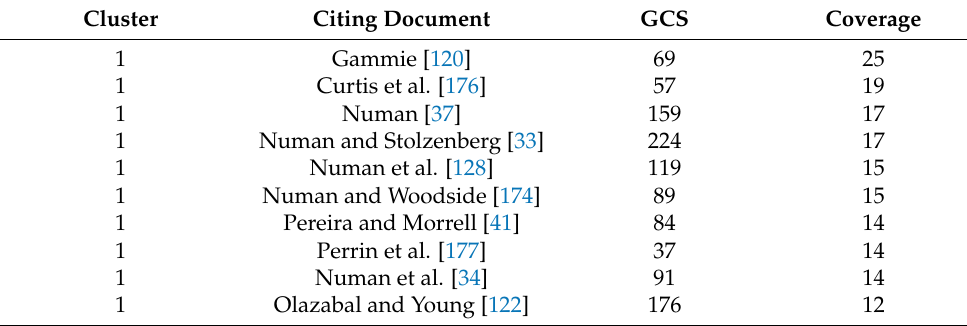
Table 6. Major 10 citing documents in cluster #1 identified using the